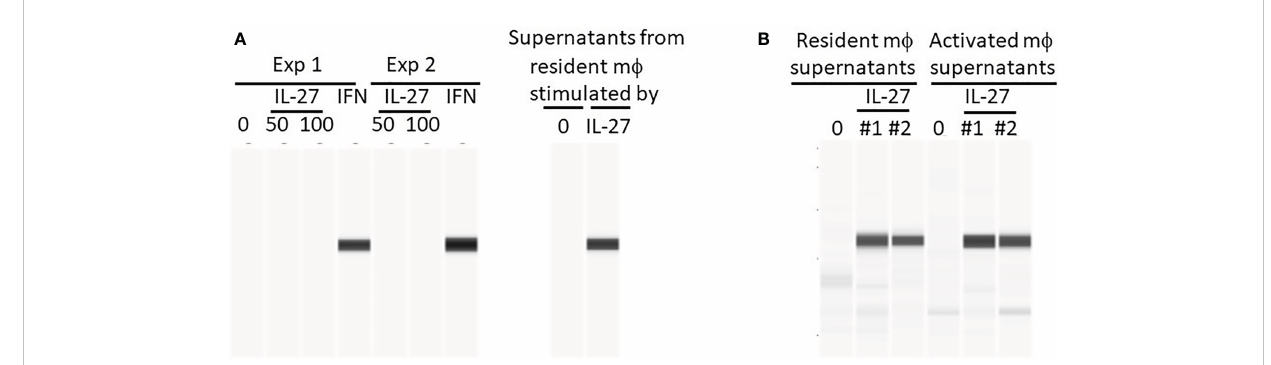
FIGURE 1 IL-27 does not directly induce Stat1 phosphorylation in murine colonoids but can induce indirectly via macrophage soluble factors. Colonoids were generated from C57BL/6 mouse colons and phosphorylation of Stat1 was detected by WES after the following stimulations: (A) Colonoids were either stimulated directly with IL-27 (50 or 100 ng/ml) or IFN g (10 ng/ml) for 24h in two experiments, or with supernatants harvested from resident peritoneal macrophages that were stimulated with IL-27 for 24h. Two experiments are shown. (B) A comparison of IL-27-induced resident versus activated m f supernatants from two experiments (#1 and #2) in induction of Stat1 phosphorylation in